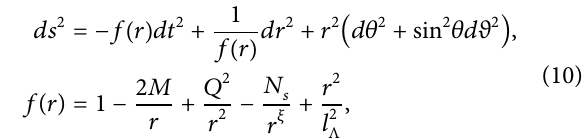
Table 1: The condition for 휌